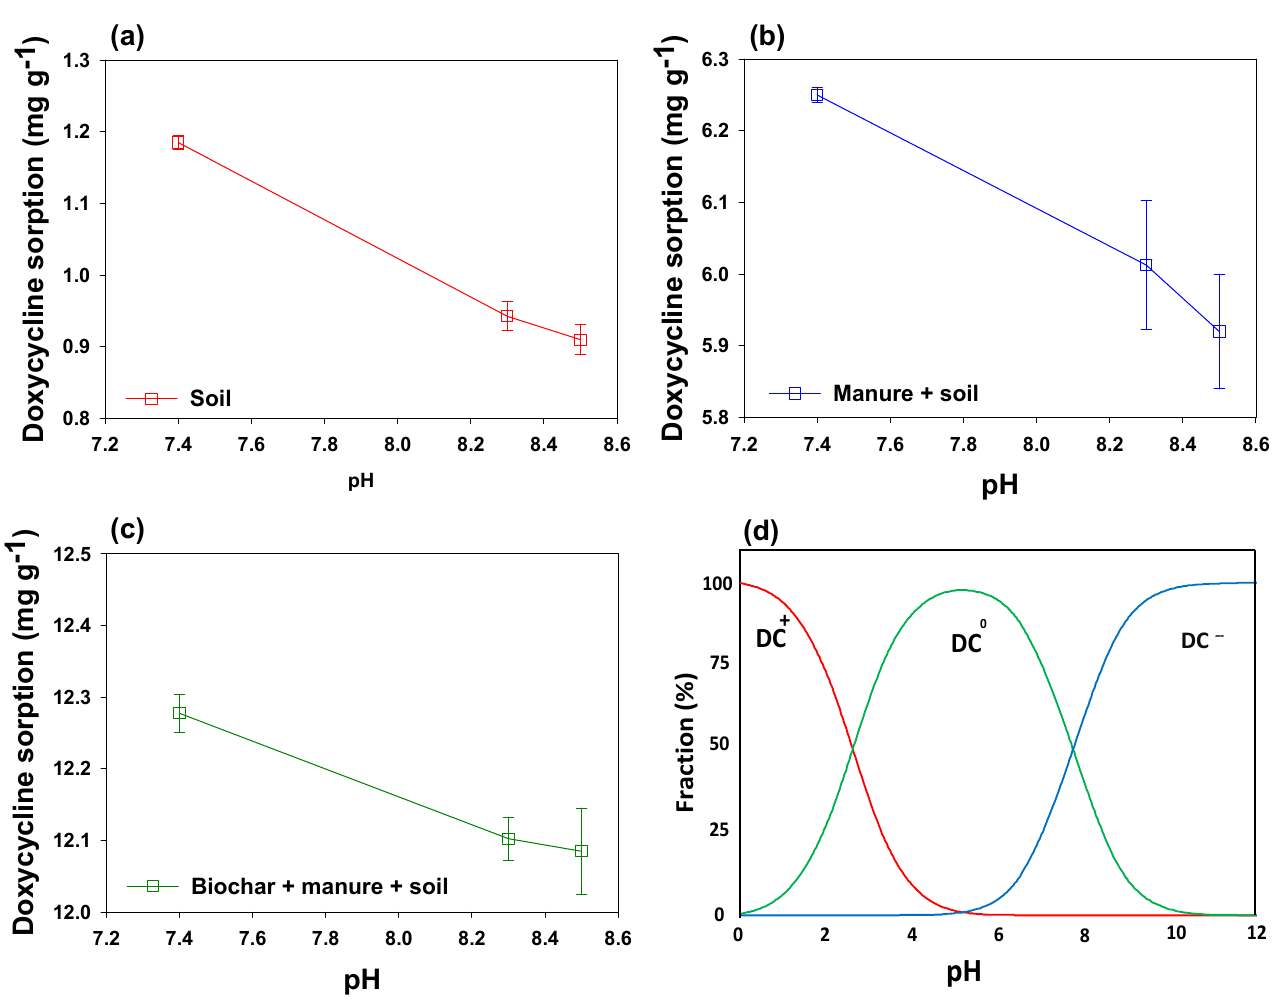
Figure 3. Effect of soil pH on doxycycline sorption onto ( a ) soil, ( b ) soil + manure, and ( c ) soil + manure + mesquite wood-derived biochar, as well as ( d ) transformation of DC forms with changing pH.